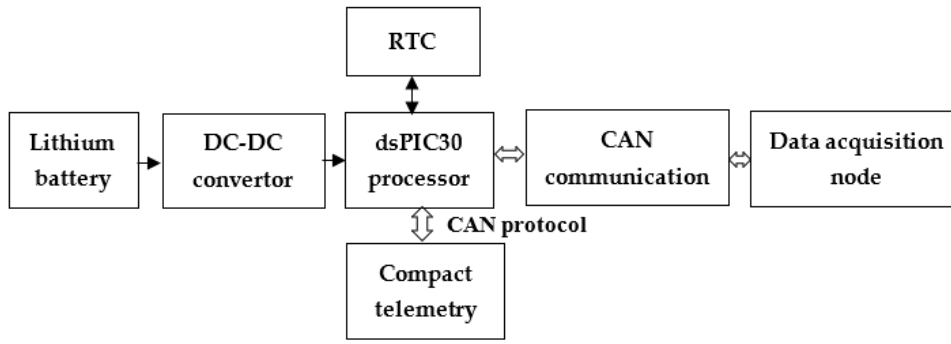
Figure 13. Structural diagram of the main control.